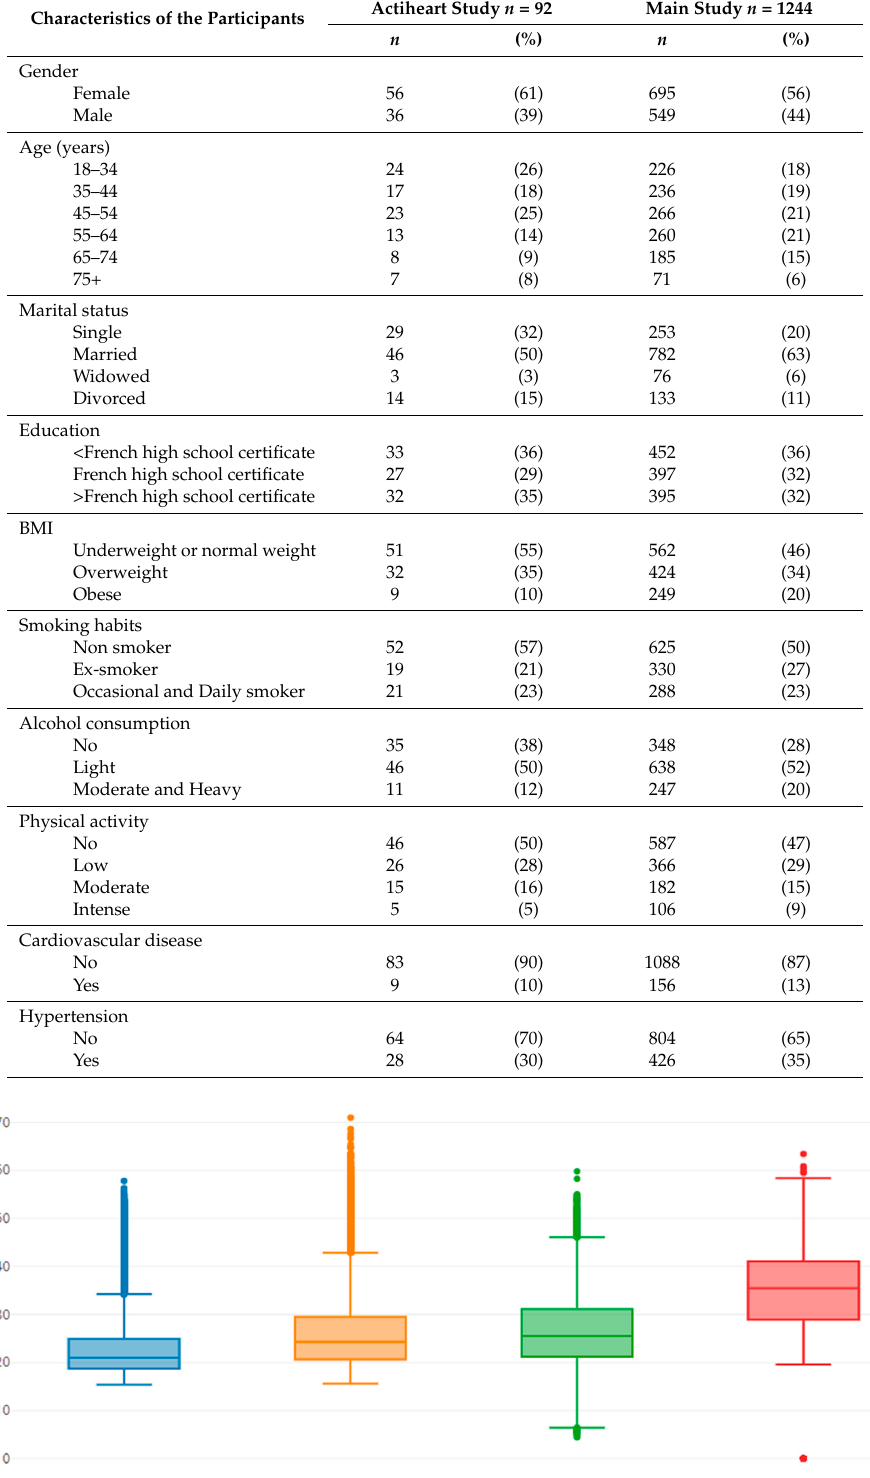
Table 1. Description of the 92 participants in the Actiheart study and of the 1244 participants in the main DEBATS (Discussion on the Health Effects of Aircraft Noise) study.